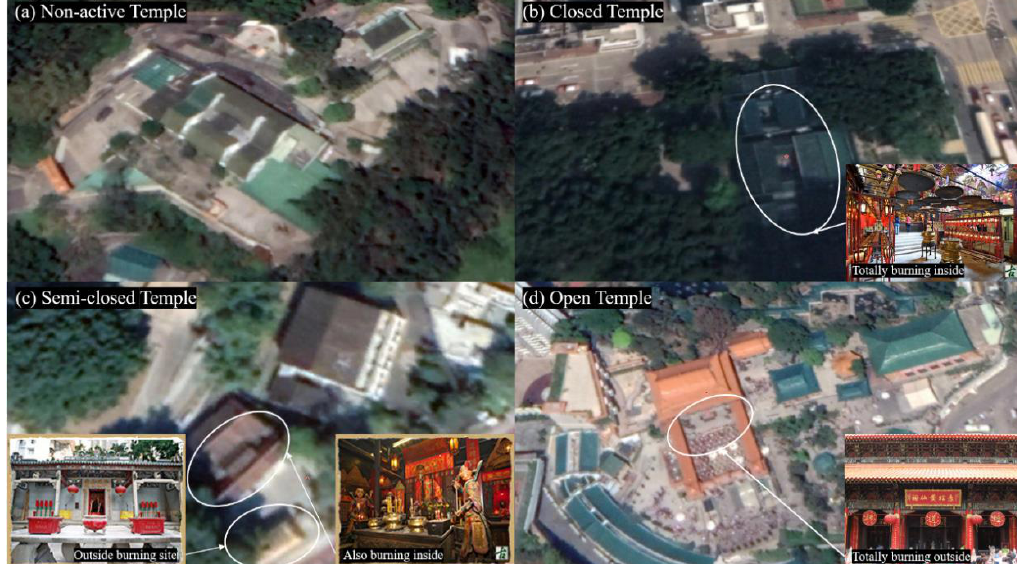
Figure 3. Four Temple Types: ( a ) non-active temple; ( b ) closed temple; ( c ) semi-closed temple; ( d ) open temple (Picture from Hong Kong Antiquities and Monuments Office https://www.amo.gov.hk and Wikipedia, accessed on 5 January 2021).